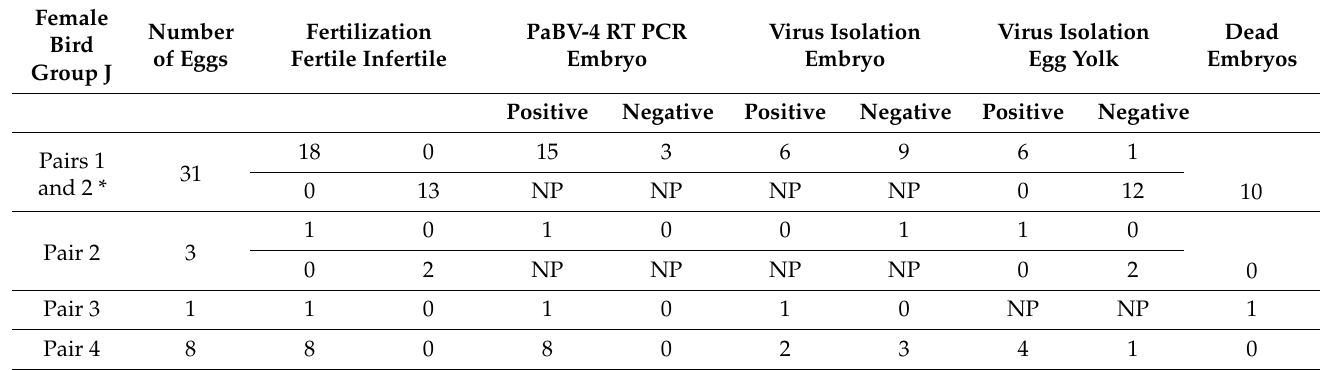
Table 4. Juvenile infected cockatiels: vertical transmission. Pairs marked with * were nesting in a group. Therefore, it was not possible to know which birds laid which eggs. Not all embryos were examined in all tests due to technical reasons. NP: not